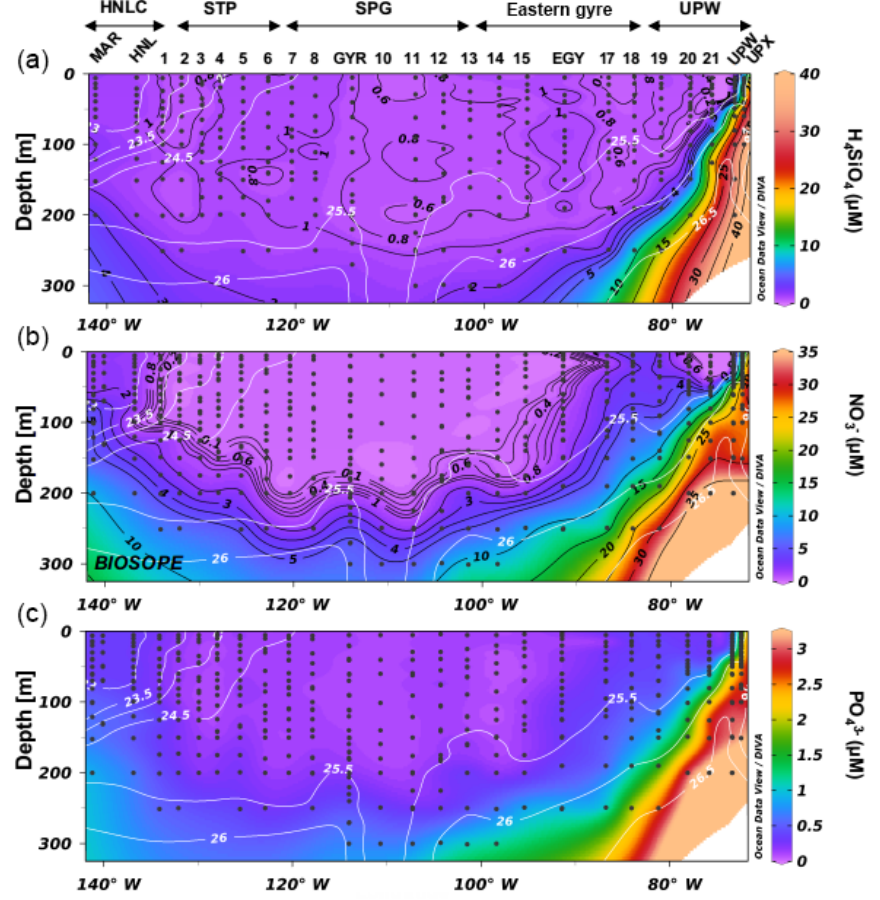
Figure 3. Nutrient distribution ( a orthosilicic acid, b nitrate, c phosphate, in µM) along the BIOSOPE cruise transect, with potential density (in kgm − 3 ) as white isoline